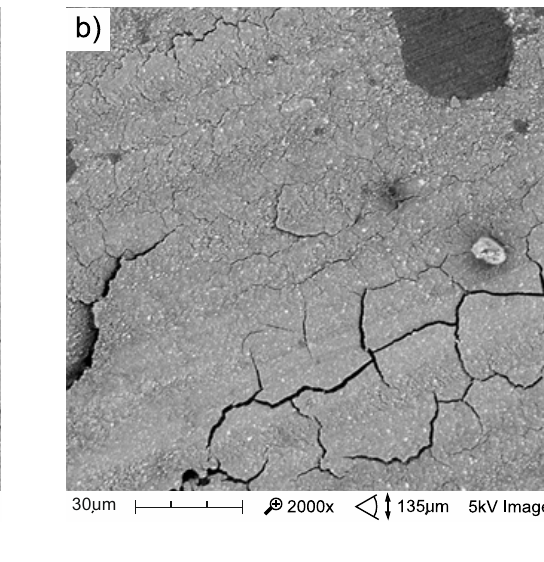
Figure 13. SEM image of a wear track of the composite Z550 with aging only in artificial saliva (AS) at 37 ° C ( a ) and after 10 4 TCs ( b ). Materials 2020 , 13 , x FOR PEER REVIEW